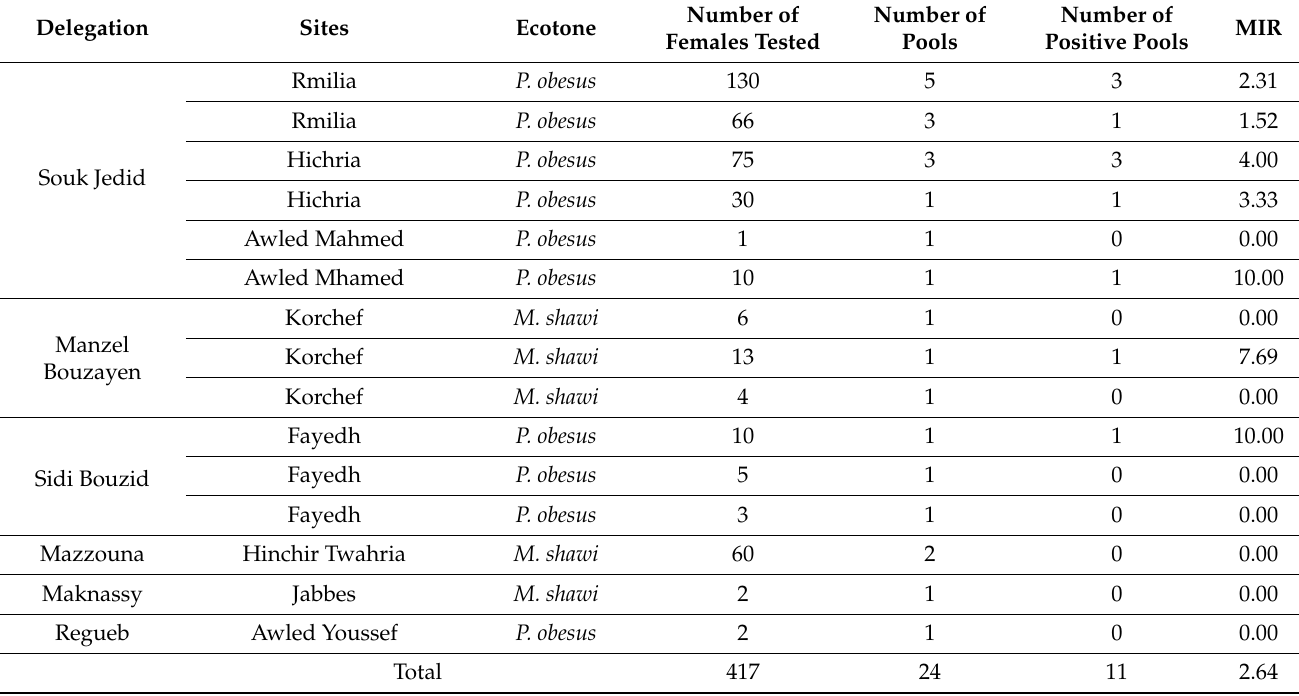
Table 3. Minimum infection rates of P. papatasi with L. major in different biotopes and delegations. Delegation Sites